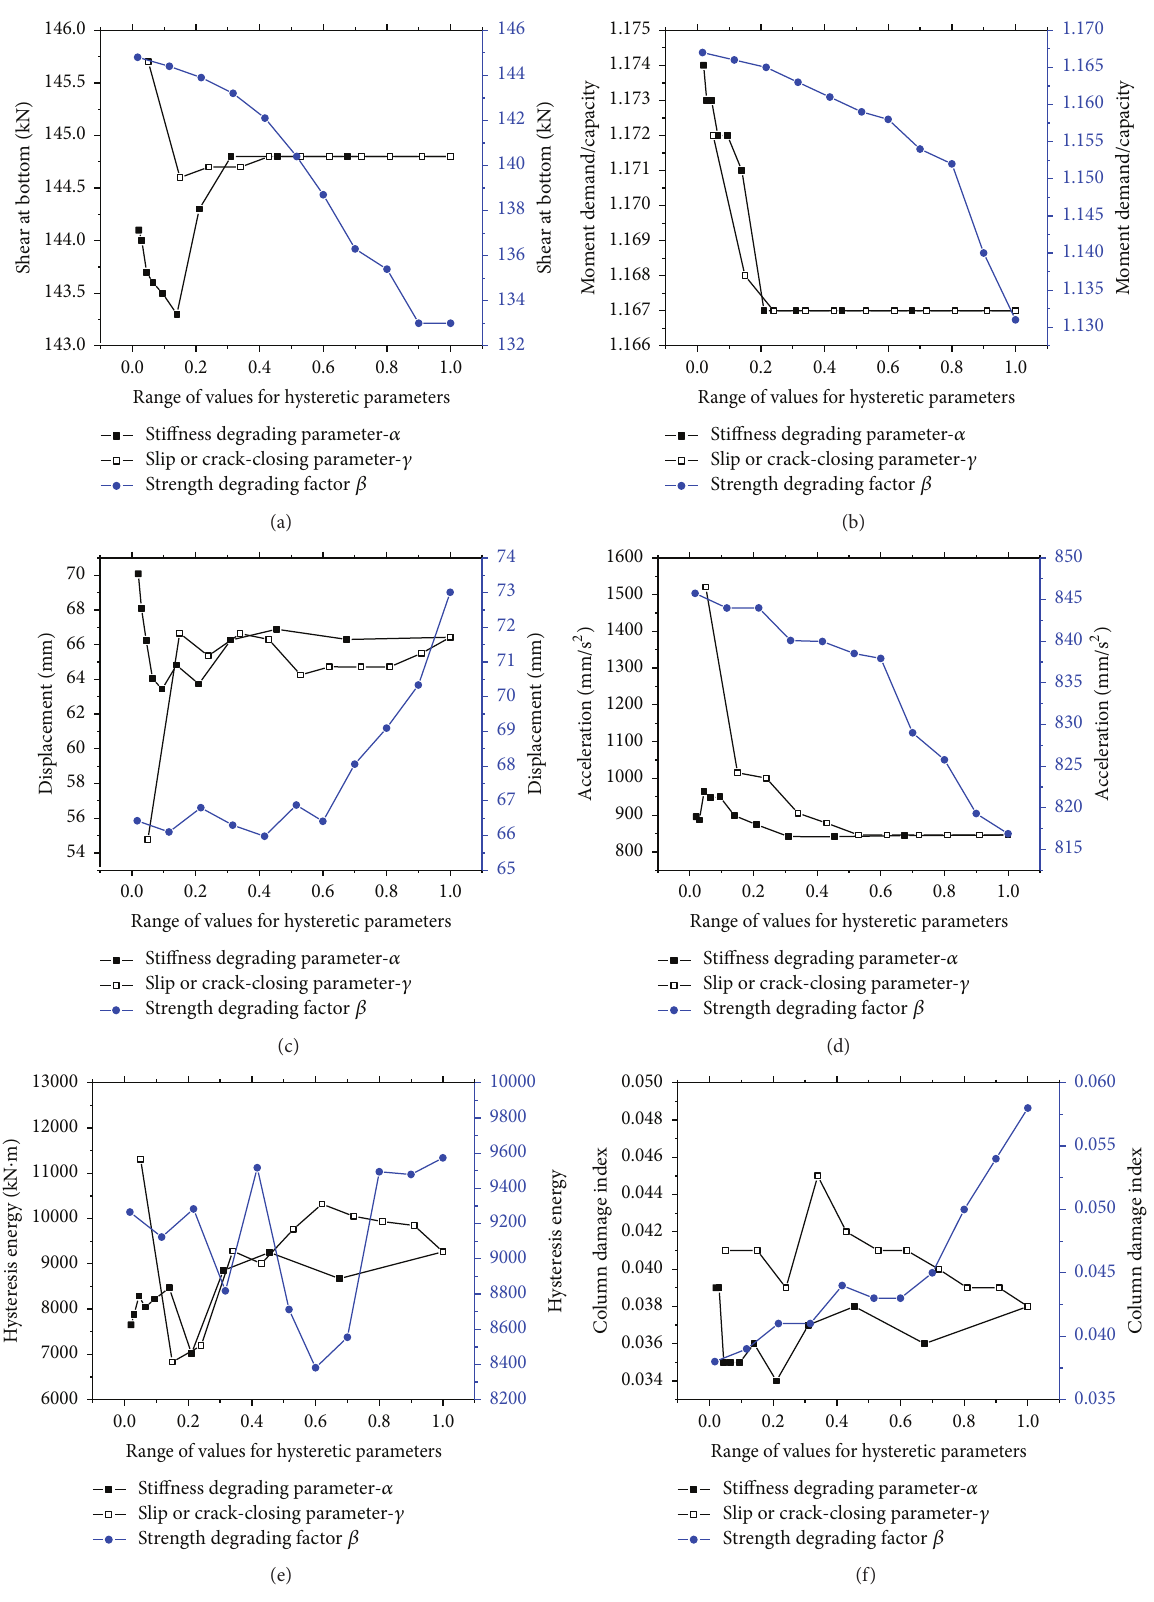
Figure 1: Influence on main structural responses of the numerical model by varying values of energy degradation parameter 𝛽 , stiffness degradation parameter 𝛼 , and fracture slip closure parameter 𝛾 . Note: for the convenience of comparative expression of various parameters in the same range, normalization processing was provided here, so that the stiffness degradation parameter 𝛼 ∈ (1.0,0.0) and the energy degradation parameter 𝛽 ∈ (0.0, 1.0)